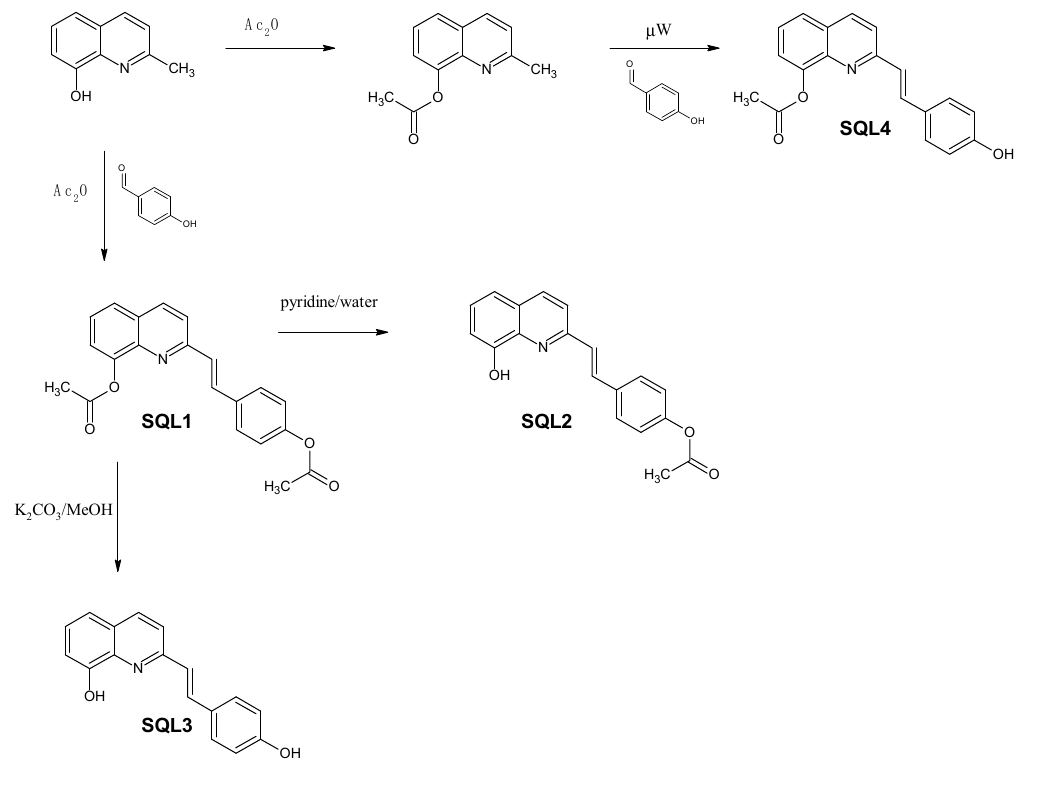
Figure 3. Synthesis of the styrylquinolines.